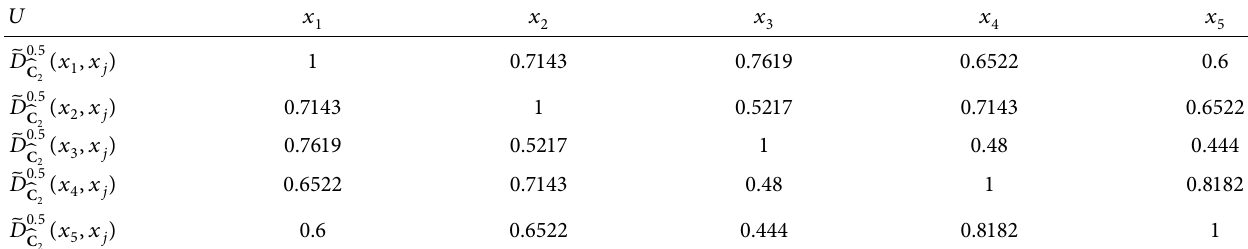
( x , x )( k,j � 1 , 2 , . .. , 5 ) k j C 2